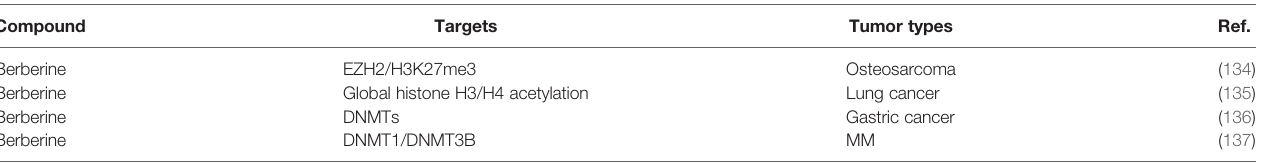
TABLE 5 | Berberine targets epigenetic enzymes for cancer